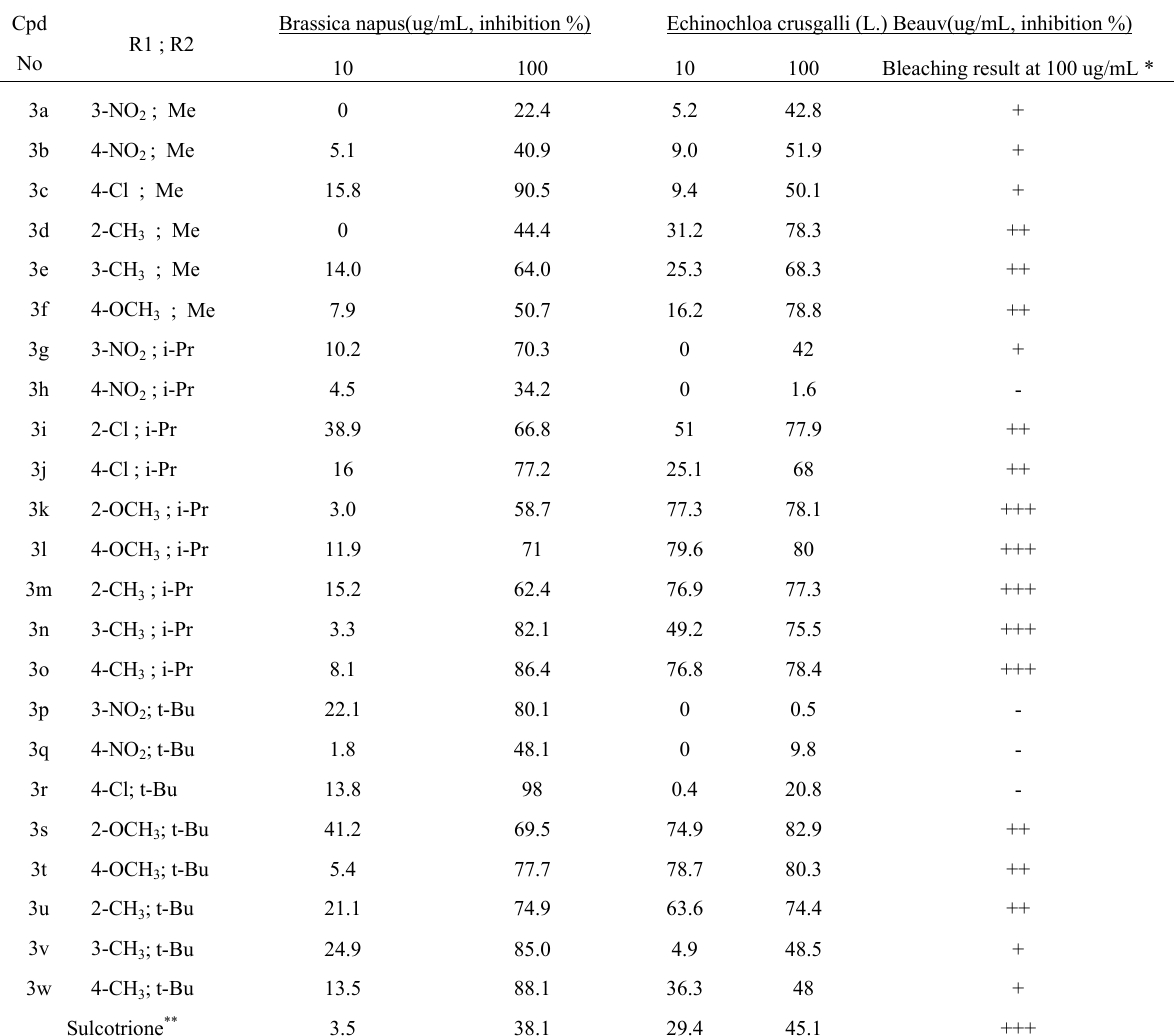
Table 1 The biological activity( % ) of compounds 3a ~ 3w against Brassica napus and Echinochloa crusgalli (L.) Beauv Brassica napus(ug/mL, inhibition